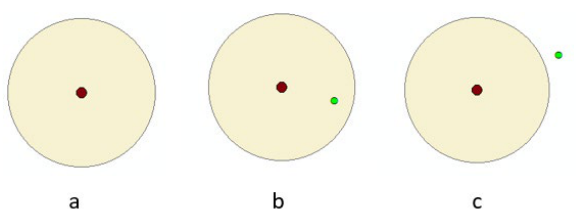
Figure 4. Buffer. Red point: Cadastral parcel point, Green point: Tehran Municipality parcel point. a) Point buffer b) The green parcel is in a buffer and matched to the red one c) The green parcel is out of buffer and not matched to the red